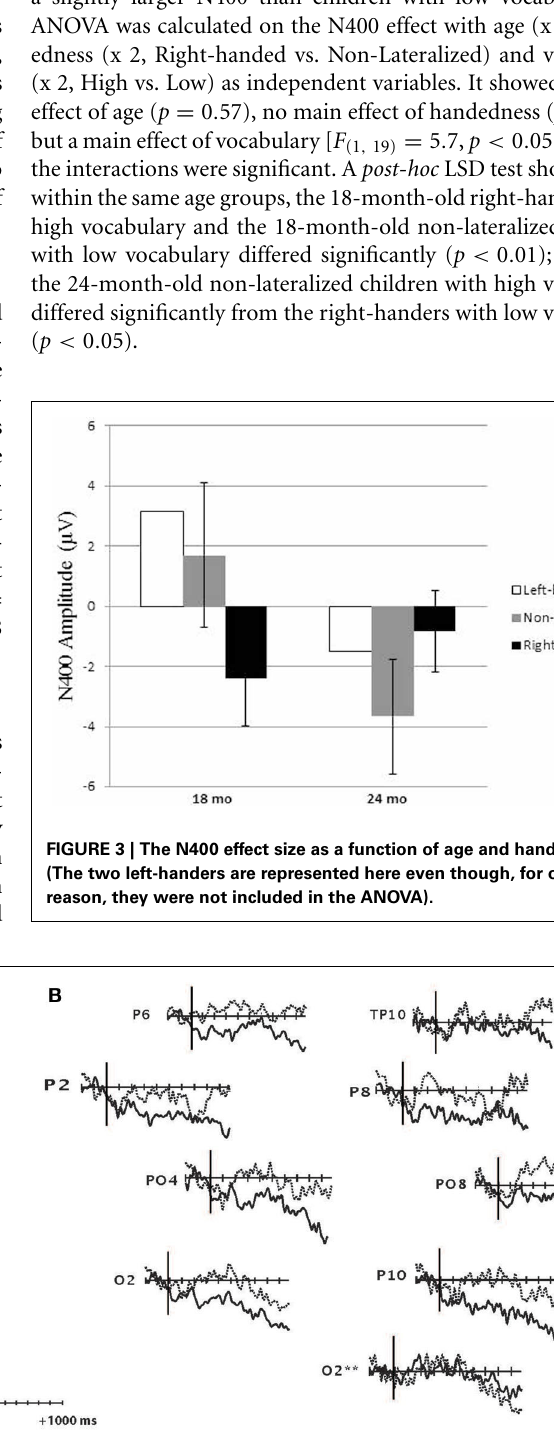
According to the 10–10 international system of electrode positions, channels 40 and 44 are both indicated as O2. The O2 ∗∗ reflects channel 44. The vertical line illustrates the target word